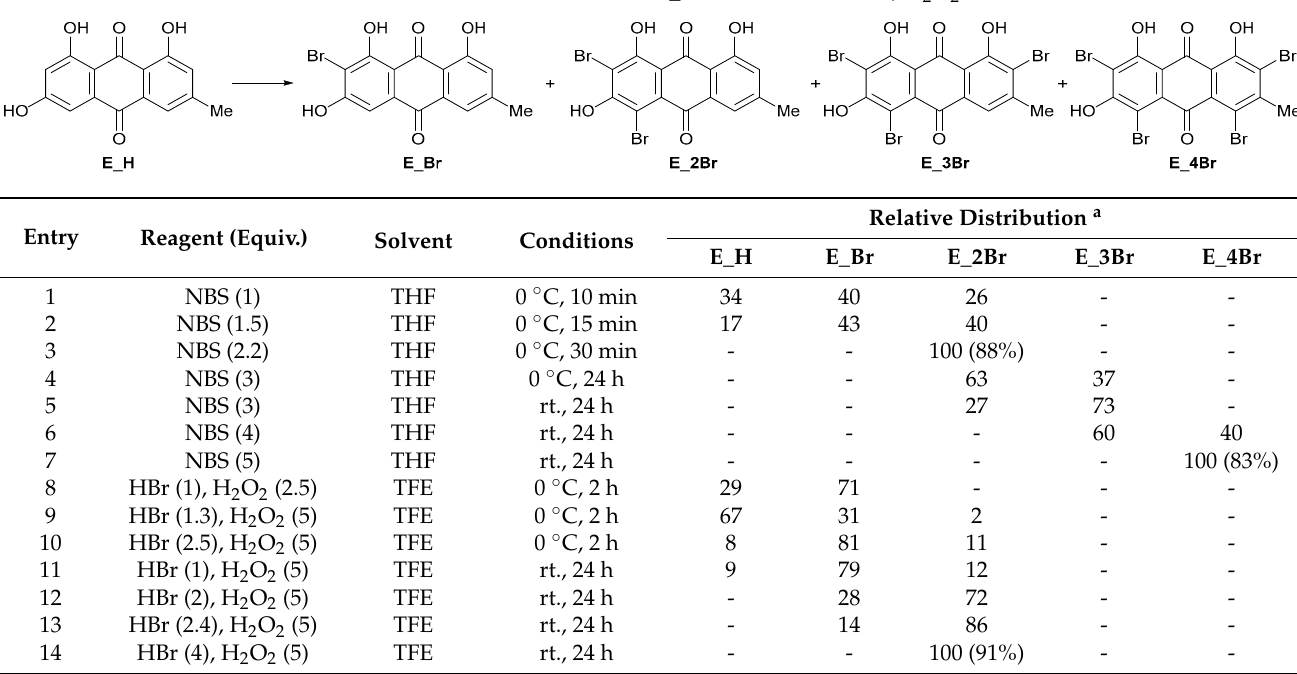
Table 2. Bromination of emodin E_H with NBS and HBr/H 2 O 2 .